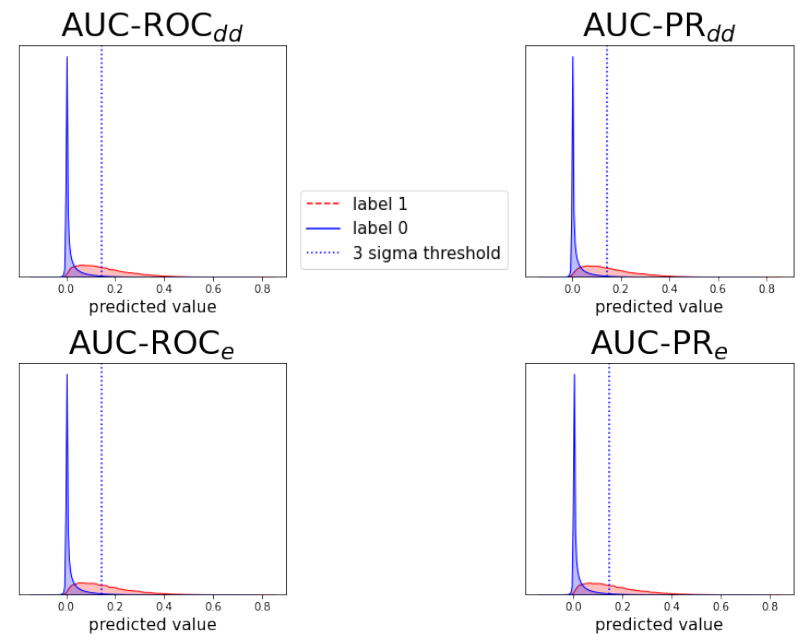
Figure A8. Analogous to Figure A6, for prediction task (cid:98) dde .